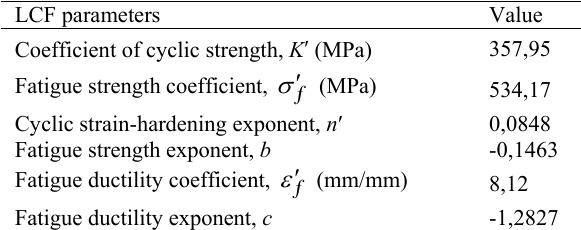
Figure 11. The plastic strain amplitude vs. stress amplitude curve Based on Figure 11, the coefficient of cyclic stren– gth, K', and the cyclic strain-hardening exponent, n', are obtained from the stress-strain plot of magnesium in the plastic region. K' and n' are shown in table 5. Table 5. Low cycle fatigue properties of Mg